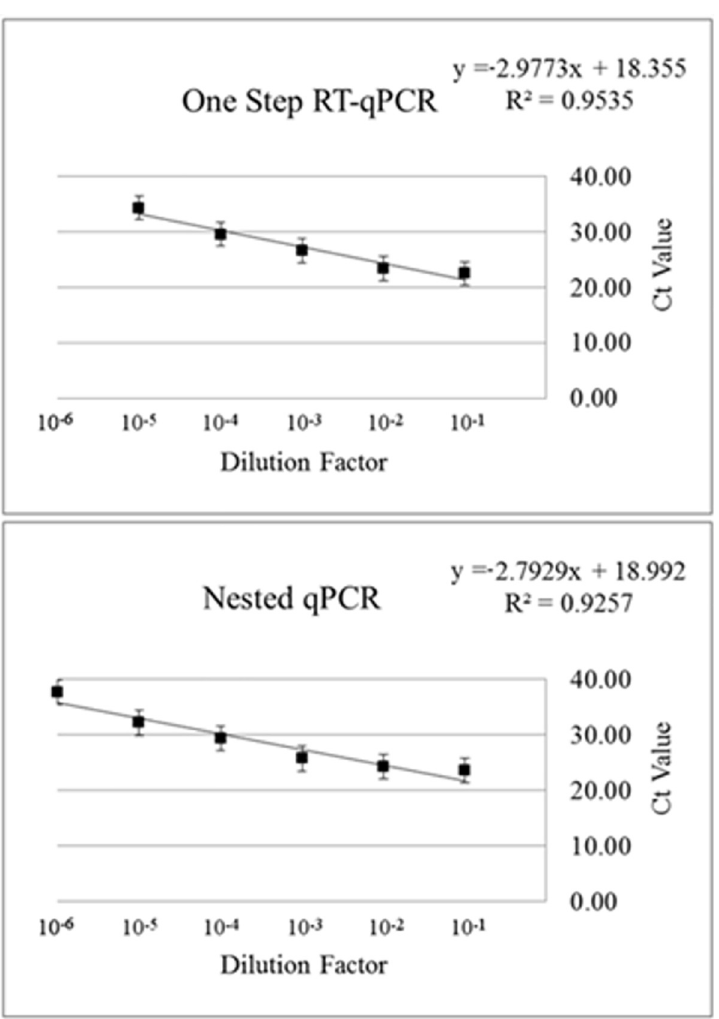
Fig 1. Comparison of standard curves generated using a one-step real-time RT-PCR [11] and a nested real-time PCR [12]. Each curve was generated using four replicates for each dilution sample tested. Standard error bars are shown for each